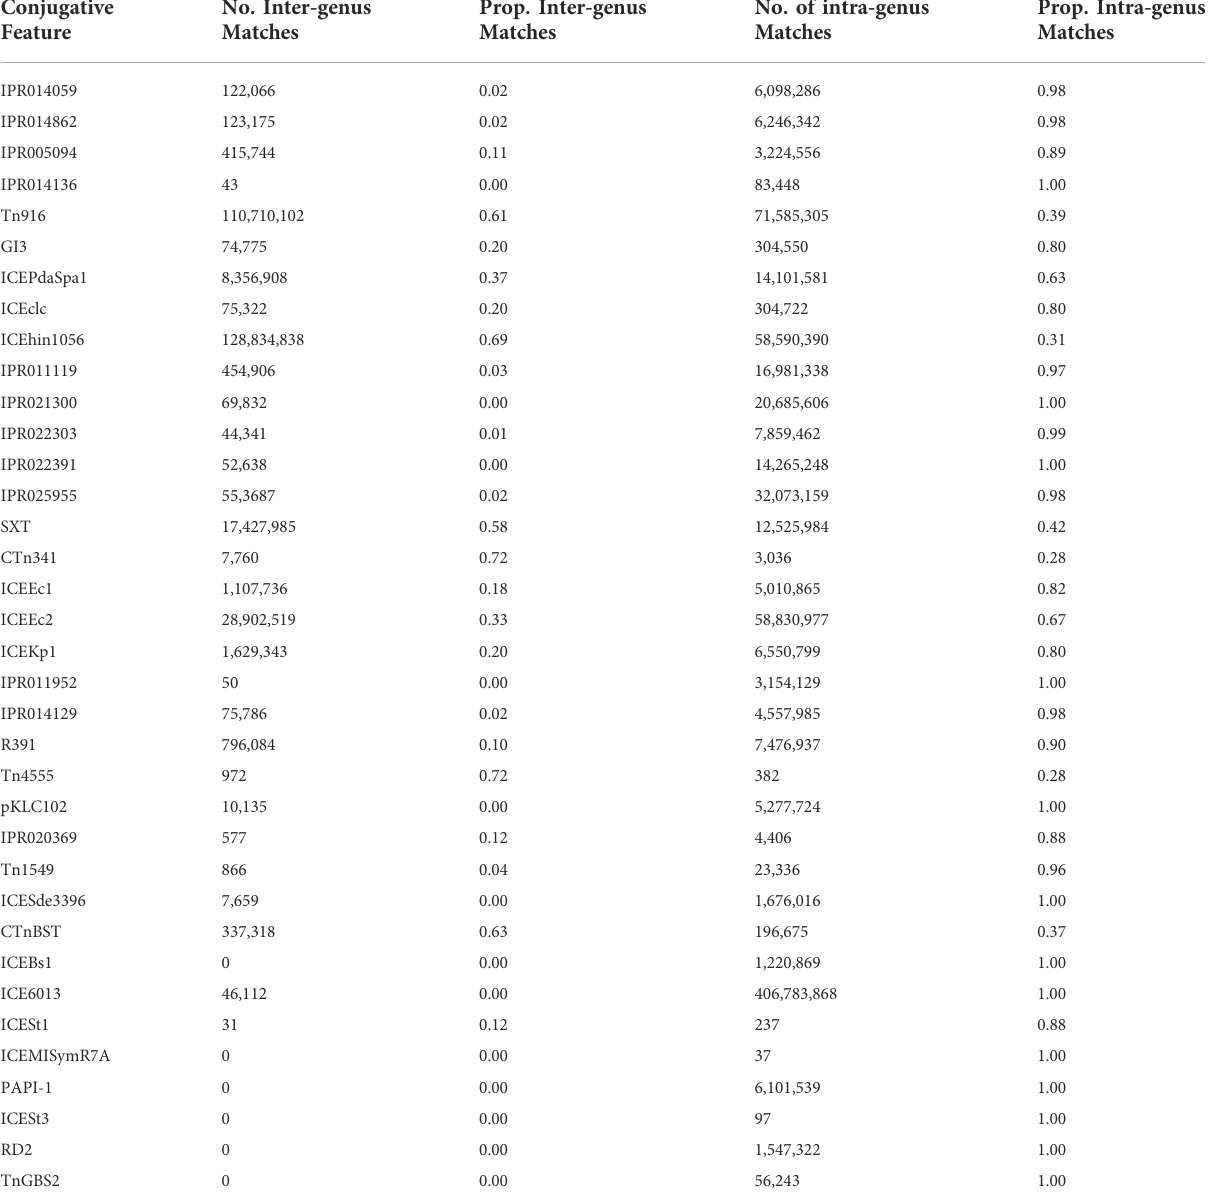
TABLE 3 Count and proportion of inter- and intra-genus detection of conjugative features. Conjugative No. Inter-genus Prop. Inter-genus No. of intra-genus Prop. Intra-genus Feature Matches Matches